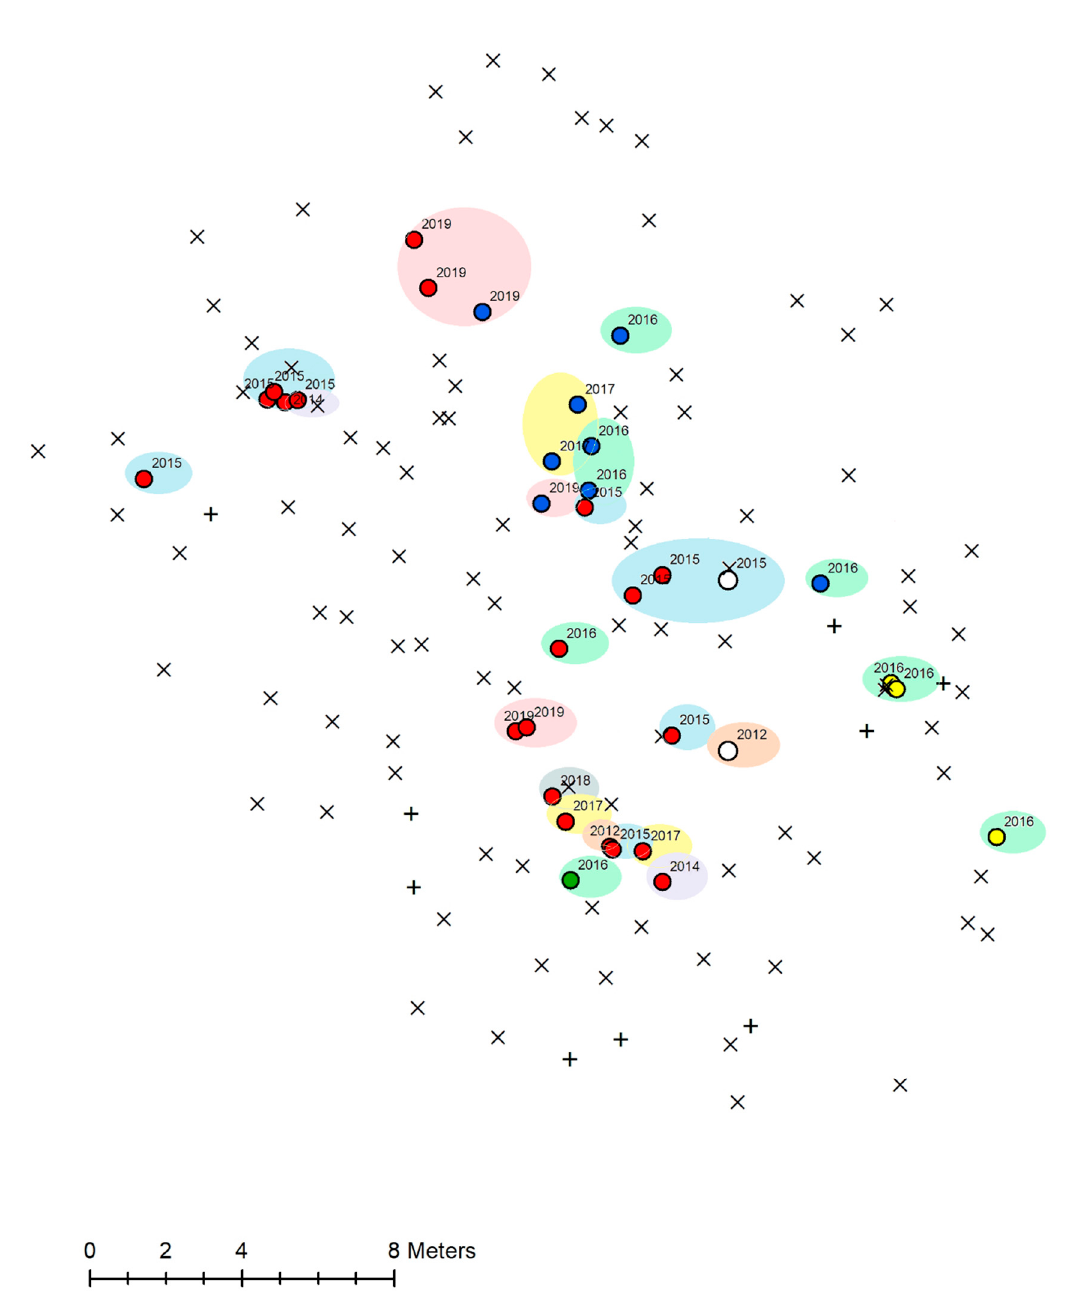
Figure 4. The spatial and temporal distribution of Heterobasidion genets in the disease center DC19 (see the supplementary data, Table S1) in the pine regeneration (generation 2). Circles represent pine seedlings infected by H. annosum s.s.; seedlings infected by the same Heterobasidion genet are marked with a circle of the same color; an open circle indicates that a Heterobasidion genet was not identified. The year next to the circle indicates the year of the seedling’s death. The trees that died in the same year are shaded with the same color. The symbol × represents living, healthy pine seedlings and the + sign living birches.